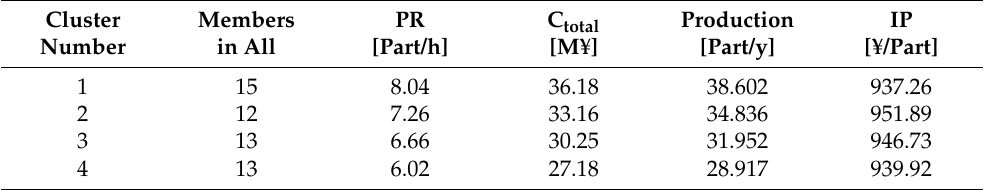
Table A6. Cluster analysis of the new approach (Case B).